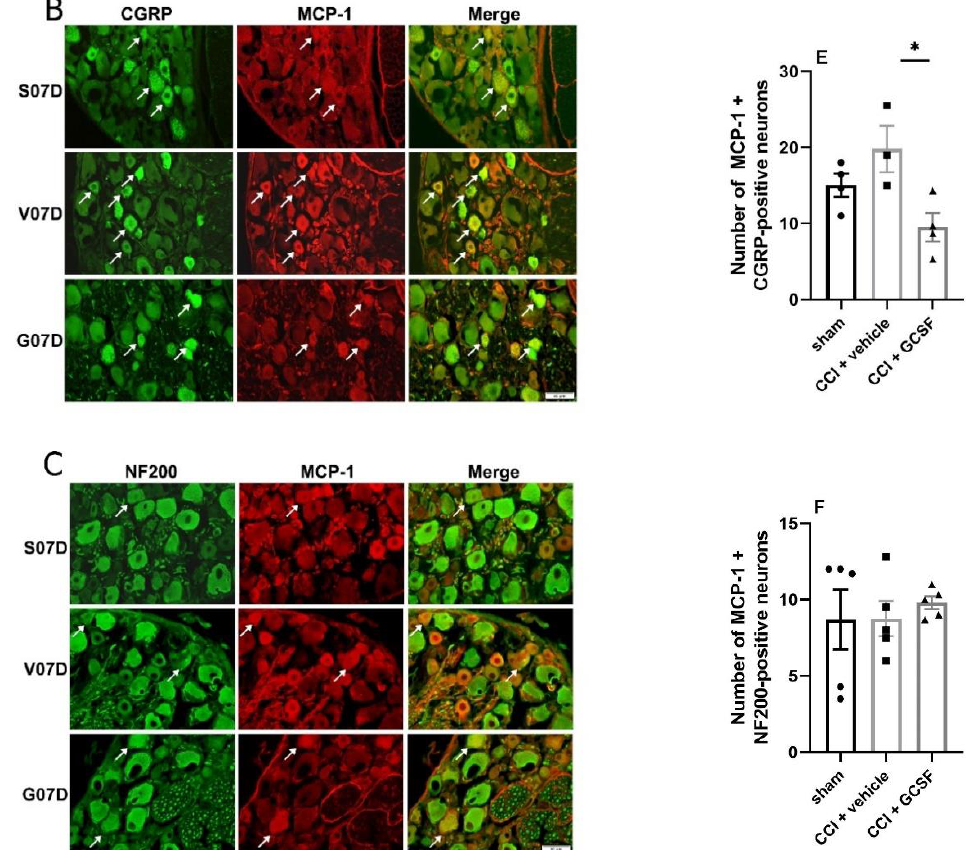
Figure 7. GCSF treatment decreased the number of MCP-1 + CGRP-positive neurons in the DRGs of CCI rats ( B , E ). Immunohistochemical studies revealed that many MCP-1-positive neurons (red) in the DRGs were co-stained with IB4 (green ( A ), a marker of small-diameter, C-fiber nonpeptidergic sensory neurons), CGRP (green ( B ), a marker of small- to medium-diameter peptidergic sensory neurons), and NF200 (green ( C ), a marker of large-diameter myelinated sensory neurons) (Figure 7A–C). Significantly fewer MCP-1 + CGRP-positive neurons were observed in the DRGs of the GCSF-treated CCI rats than in the DRGs of the vehicle-treated CCI rats on the 7th day after nerve injury ( E ). There was a tendency for the GCSF-treated CCI rats to exhibit fewer MCP-1 + IB4-positive neurons in the DRGs than the vehicle-treated CCI rats and sham-operated rats. However, the di ff erences were not statistically significant ( D ). In contrast, there were no significant di ff erences in the number of MCP-1 + NF200-positive neurons in the DRGs between the di ff erent groups ( F ) (one-way ANOVA, post hoc Tukey’s test or Kruskal–Wallis, post hoc Mann–Whitney rank-sum test, if appropriate; Day 7: n = 4 per group). Scale bars = 50 µ m. The arrows indicate MCP-1-positive / IB4-positive, MCP-1-positive / CGRP-positive, and MCP-1-positive / NF200-positive neurons. * p <